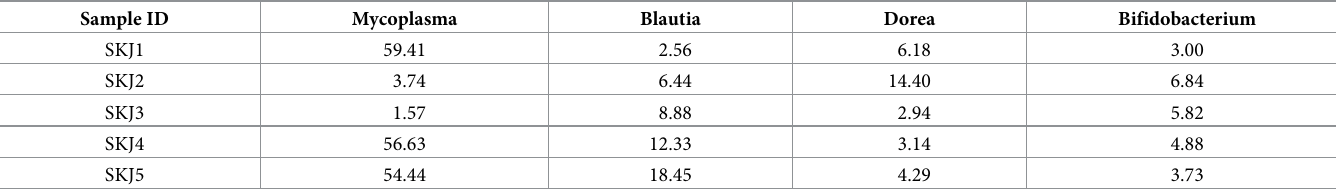
Table 5. Gut bacterial ecosystem at genus level. Sample